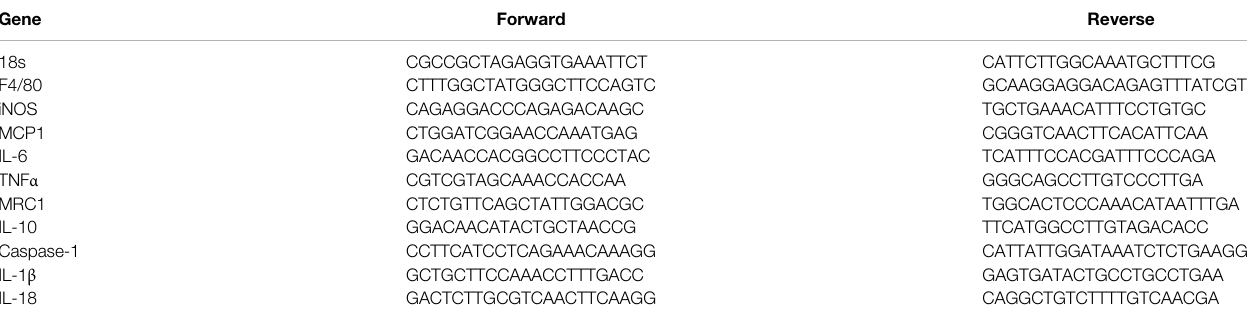
TABLE 1 | Primer sequences (5 ′ to 3 ′ ).